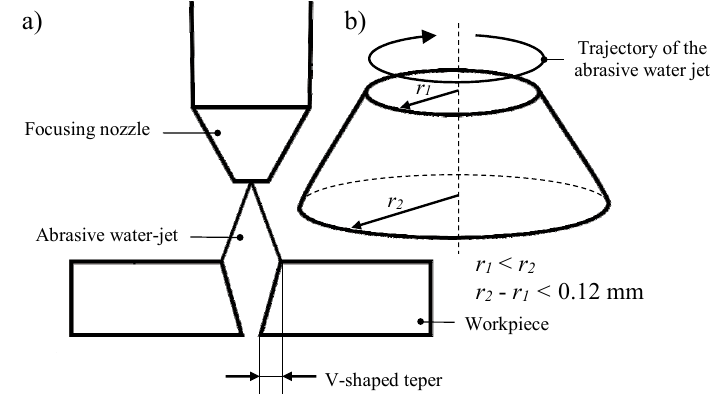
Figure 2. Phenomena occurring during material cutting with a high-pressure AWJ, important in context of the quality of this process: ( a ) formation of a V-shaped taper; ( b ) convergence effect.